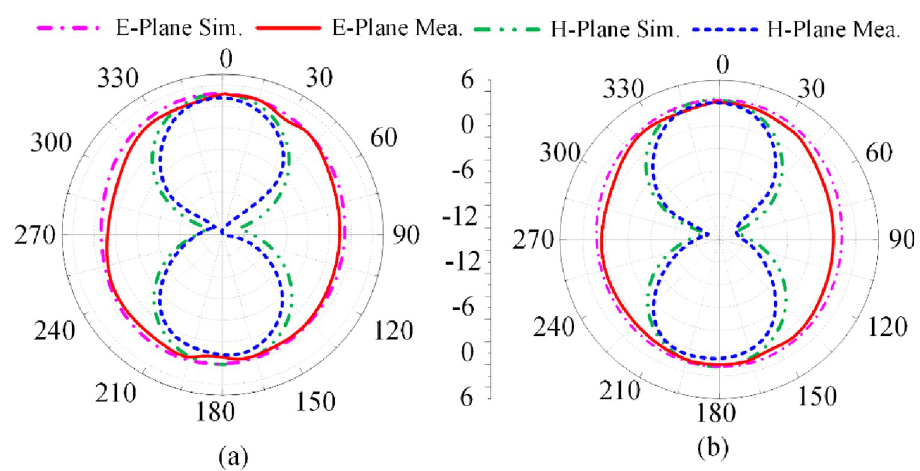
Fig 6. Radiation pattern of proposed antenna when both PIN diodes are reverse biased at (a) 3.7 GHz, and (b) 4.2 GHz.